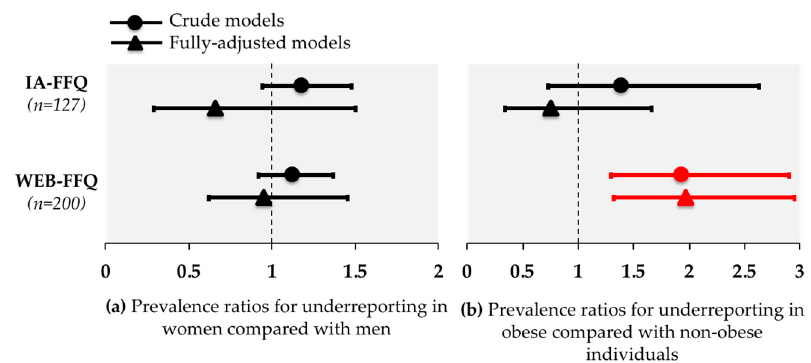
Figure 2. Log-binomial regression analysis showing prevalence ratios with 95% CI for under-reporting in: ( a ) women vs. men and; ( b ) in obese vs. non-obese individuals. Crude models are shown with circles and adjusted models are shown with triangles. Under-reporters are individuals of which their corresponding rEI:mER ratio is below 0.79. CI: confidence interval; FFQ: food frequency questionnaire; IA: